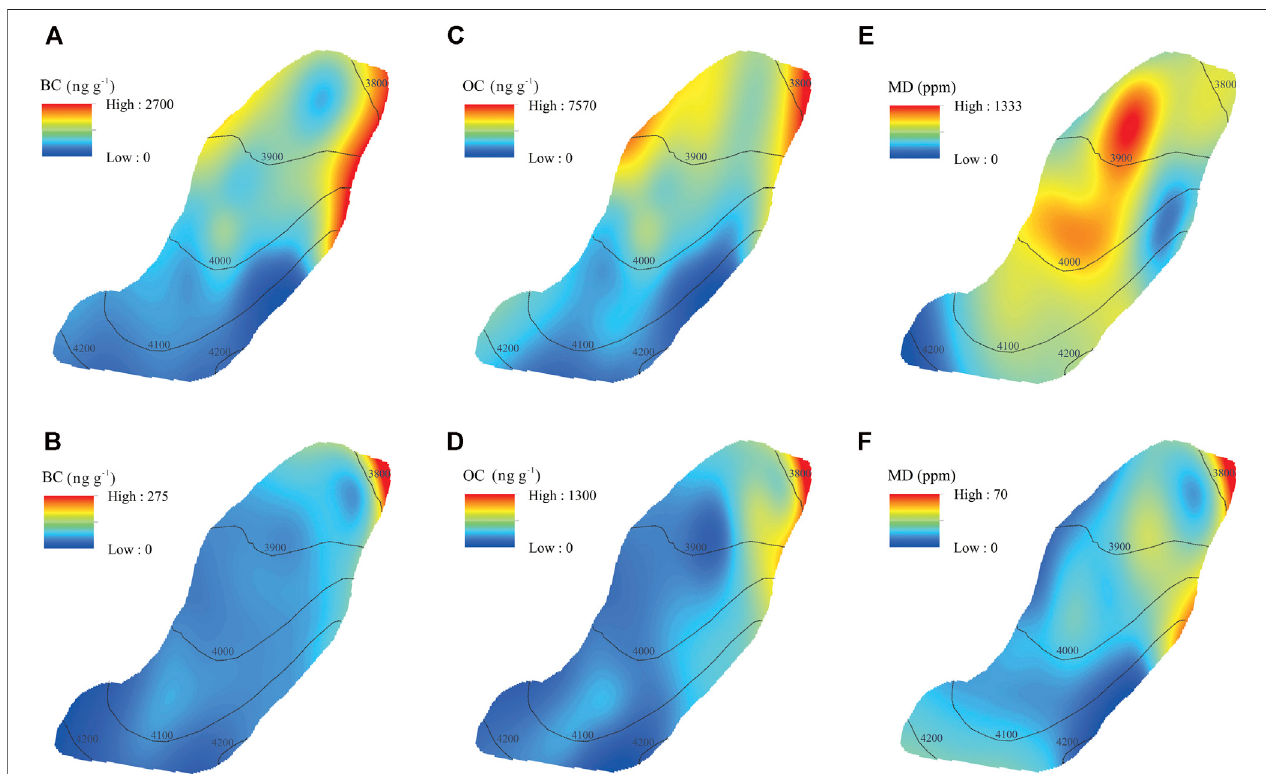
FIGURE 6 | Spatial variations of BC in the surface snow/ice. (A) , (C), and (E) BC, OC, and MD concentrations on 2 August, glacier surface mainly covered by granular ice; (B) , (D) , and (F) BC, OC, and MD concentrations on 12 August, glacier surface mainly covered by fresh snow.